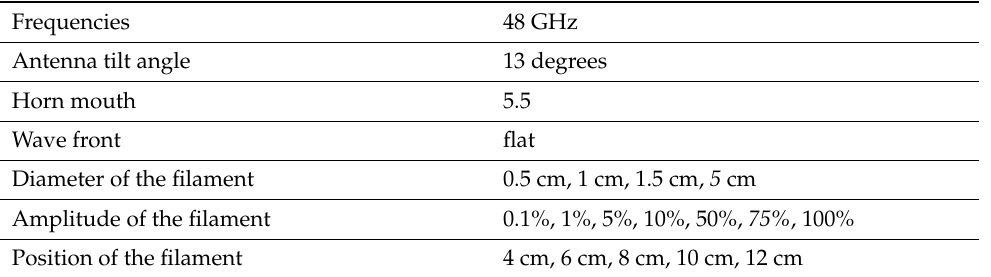
Table 3. Parameters of the performed modelling for the motion of circular